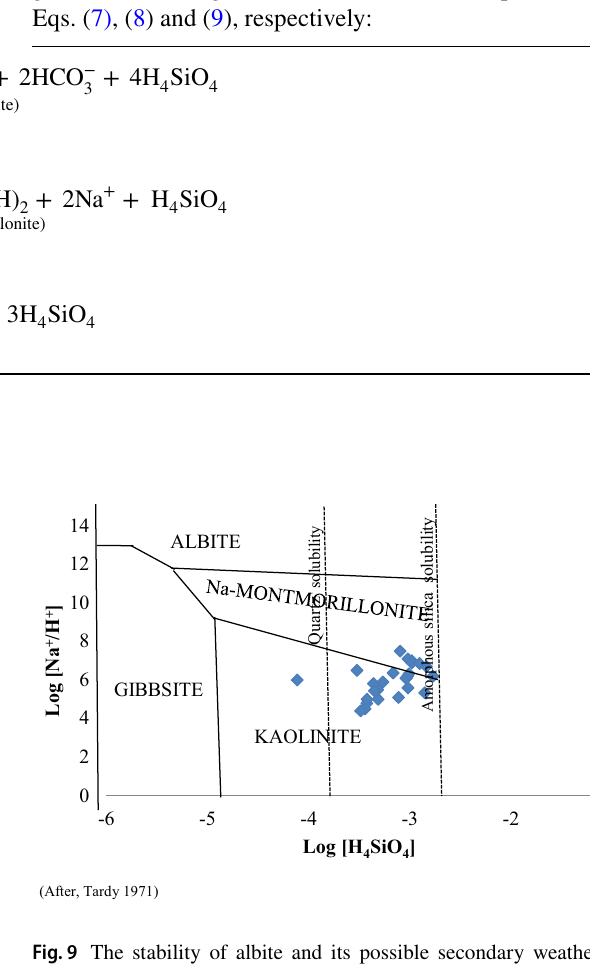
−I ) vs. Ca + Mg (meq L −I ) for groundwa- Fig. 8 Plot of HCO 3 (meq L ter within the Asutifi-North district